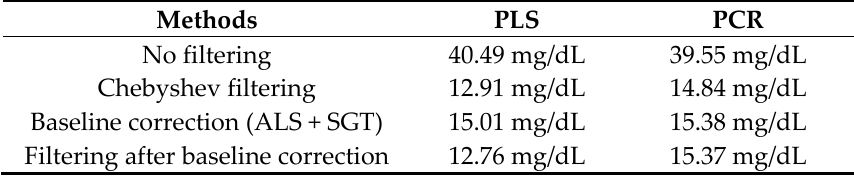
Table 1. Comparison of PLS and PCR for raw and different preprocessed